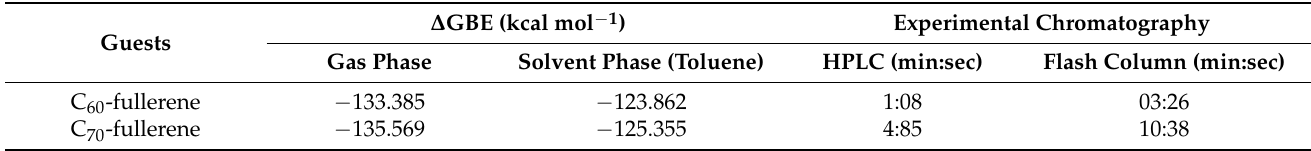
Table 2. Gas and solvent phase DFTB/mio-1-1 Gibbs free binding energies of C 60 ⊂ butylpyrogallol[4]arene and C 70 ⊂ butylpyrogallol[4]arene alongside HPLC and flash column chromatographic retention times. ∆ GBE (kcal mol − 1 ) Experimental Chromatography Guests Gas